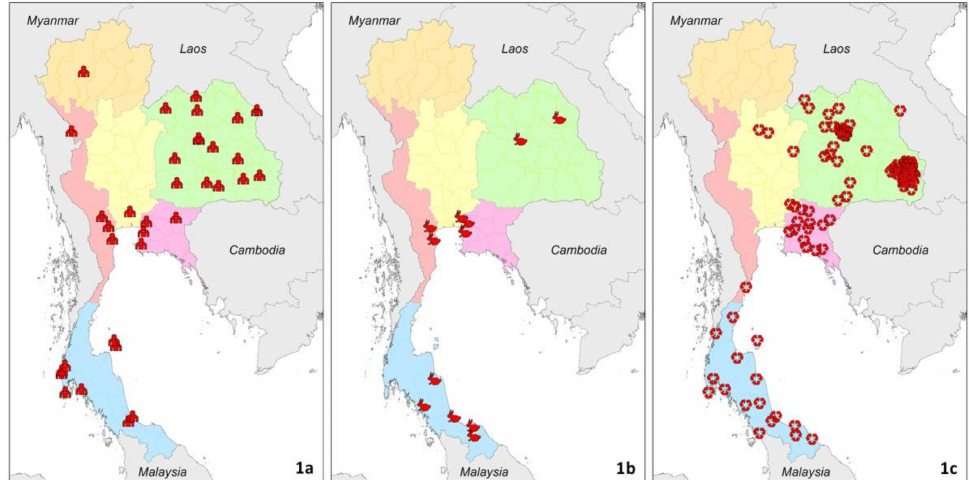
Figure 1. Evidence and distribution of melioidosis in Thailand from 1910 to 2015. Red icons represent geolocated records of culture-confirmed human cases ( 1a ), culture-confirmed animal cases ( 1b ) and presence of B. pseudomallei ( 1c ). Green, orange, pink, rose, blue, and yellow colors represent Northeast, North, East, West, South, and Central Thailand, respectively. Interactive data are available online